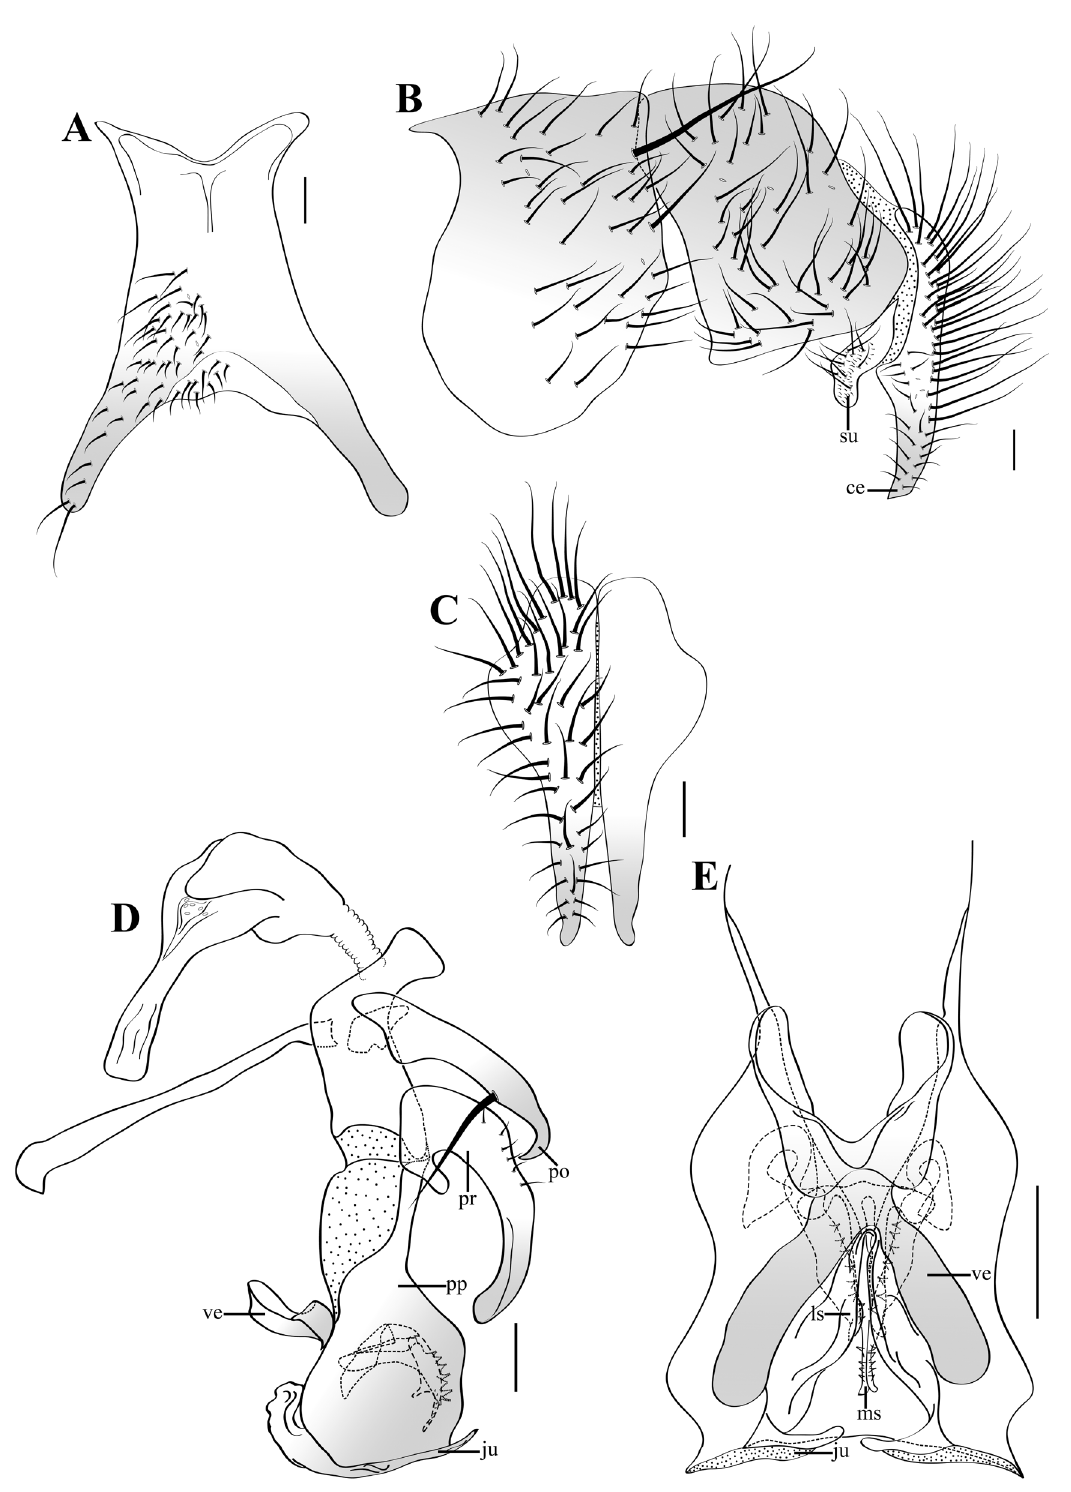
Fig. 4. Dexosarcophaga jandainae sp. nov., ♂, holotype (MNRJ [lost]). A . Sternite 5, ventral view. B . Syntergosternite 7 + 8, epandrium, cercus and surstylus, lateral view. C . Cerci, posterior view. D . Phallus and associated structures, lateral view. E . Distiphallus, ventral view. Abbreviations: see Material and methods. Scale bars = 0.1